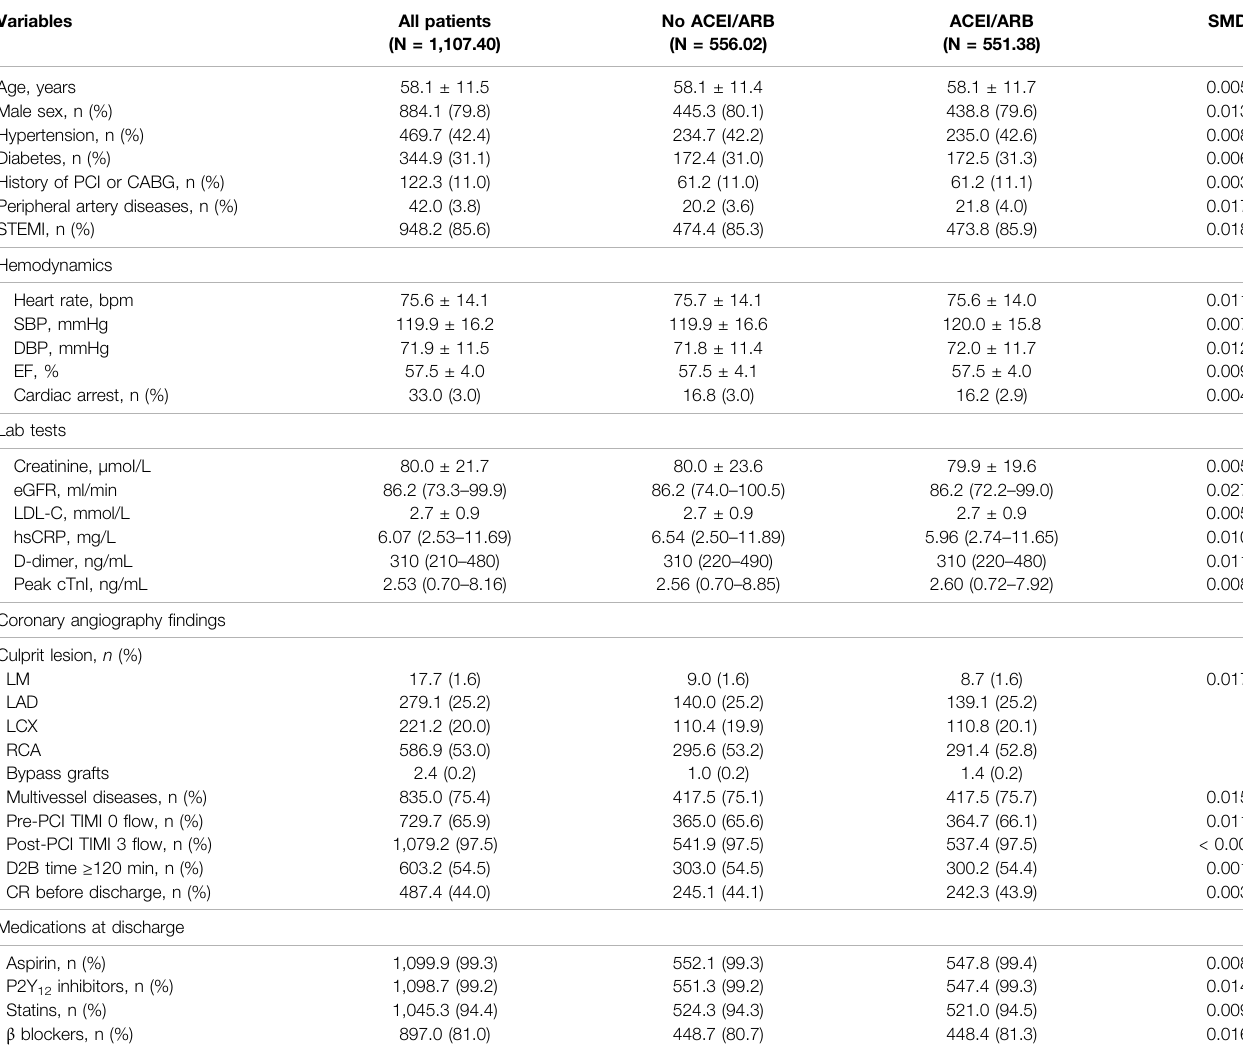
TABLE 3 | Baseline characteristics of patients in the propensity matching weight dataset strati fi ed by ACEI/ARB medication. Variables All patients (N =